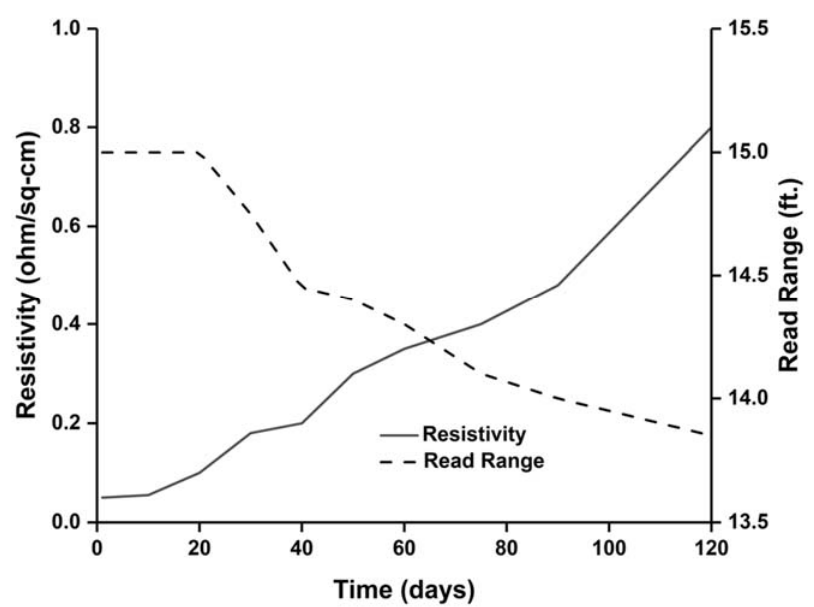
Figure 7. Resistivity and read range of the proposed tag antenna with respect to time.